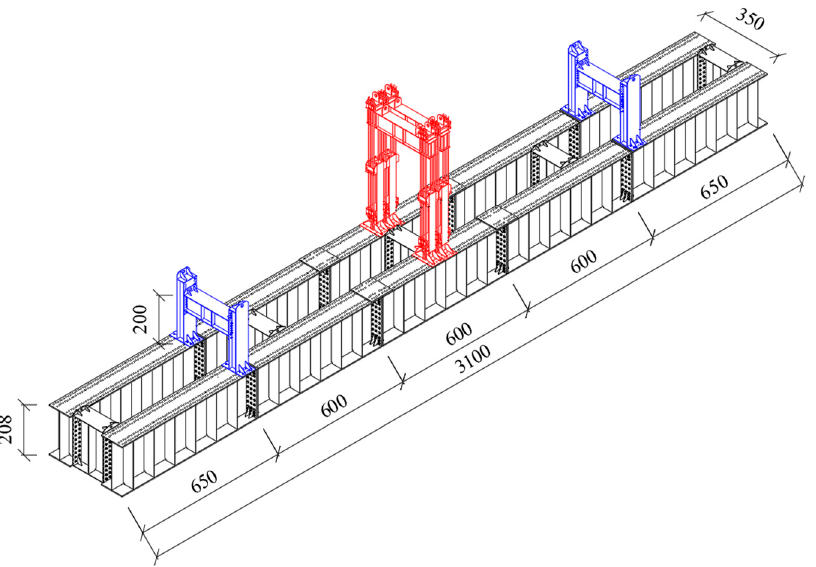
Figure 7. Technical drawing of the reaction steel frame in black, supporting frames in blue and loading frames in red (in cm).